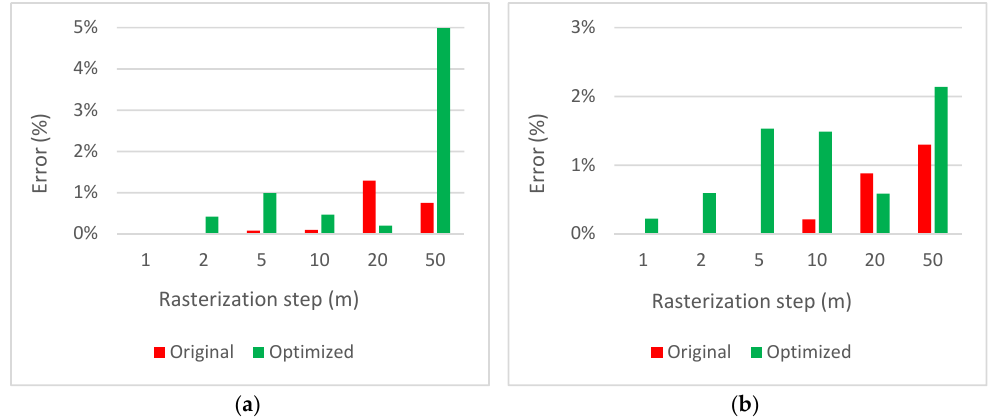
Figure 7. Coverage errors for the original and optimized versions of the algorithm for the solution evaluation: ( a ) number of waypoints N = 5; ( b ) number of waypoints N = 10.